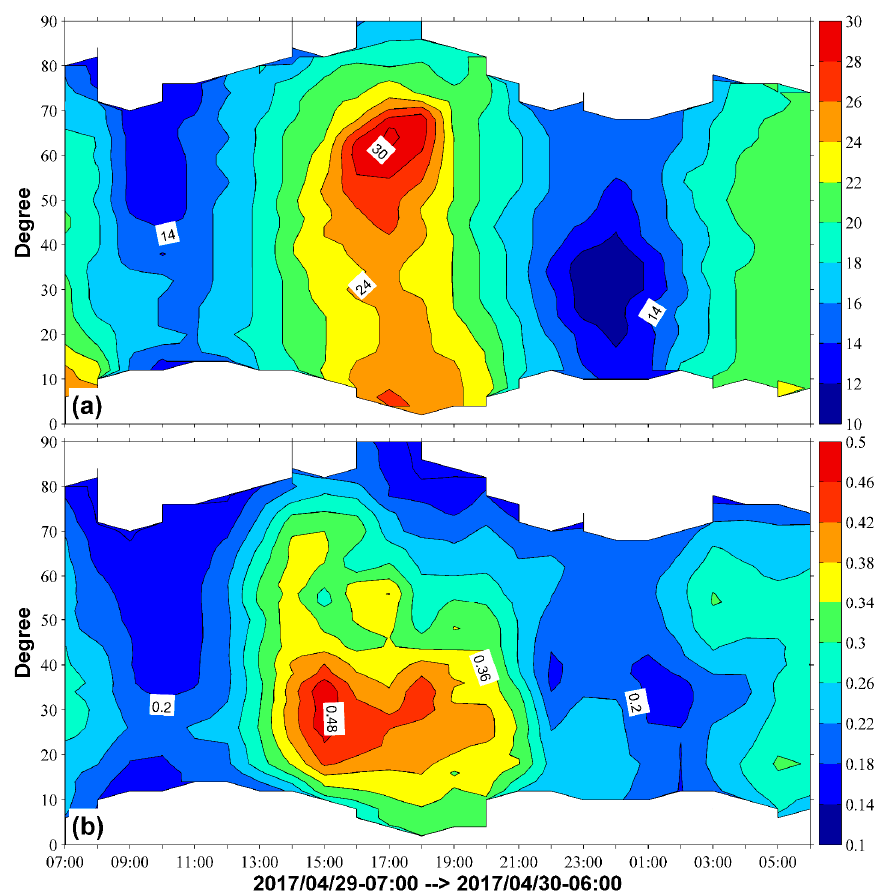
Figure A1. Spatial-temporal variations of ( a ) the front position ( D f , distance from the center point of the strait to the thick gray line in Figure 3) and ( b ) the front intensity ( T Gf , magnitude of the SST gradient on the thick gray line in Figure 3). The ordinate is angle for 46 rays starting from the strait (Figure 1d).